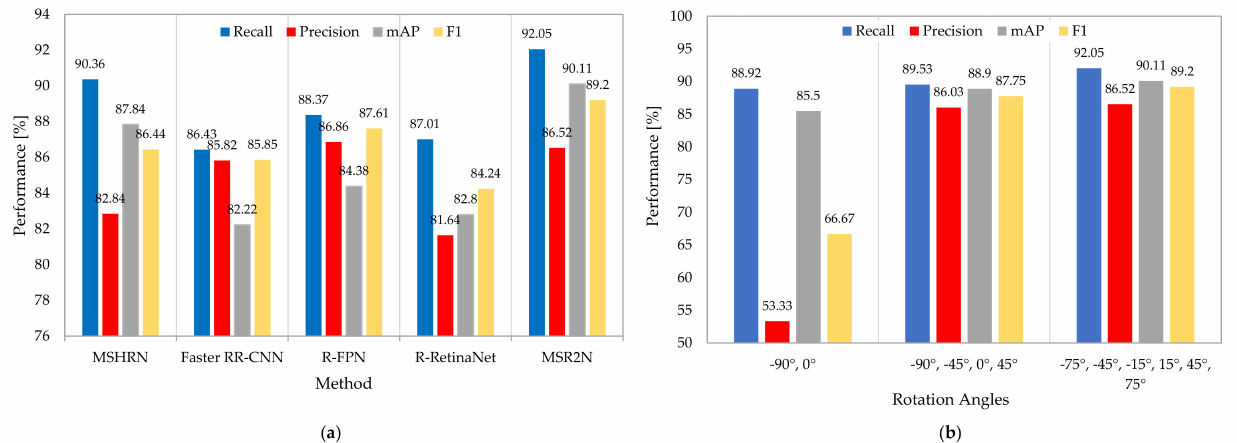
Figure 5. The experimental results of the multi-stage rotational region-based network (MSR2N): ( a ) results of different methods on the SAR ship detection dataset (SSDD); ( b ) results of rotation angles (MSR2N) (redrawn based on data in Pan et al. [63]).